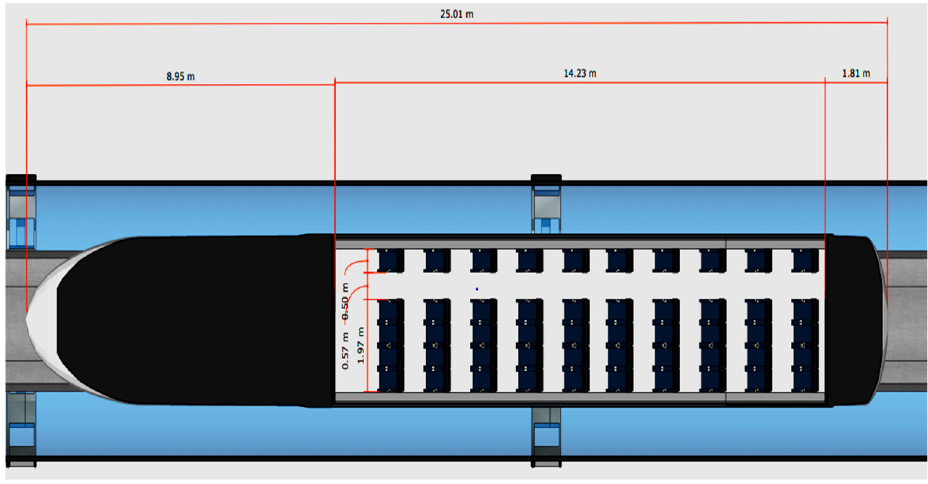
Figure 2. Medium-capacity capsule.